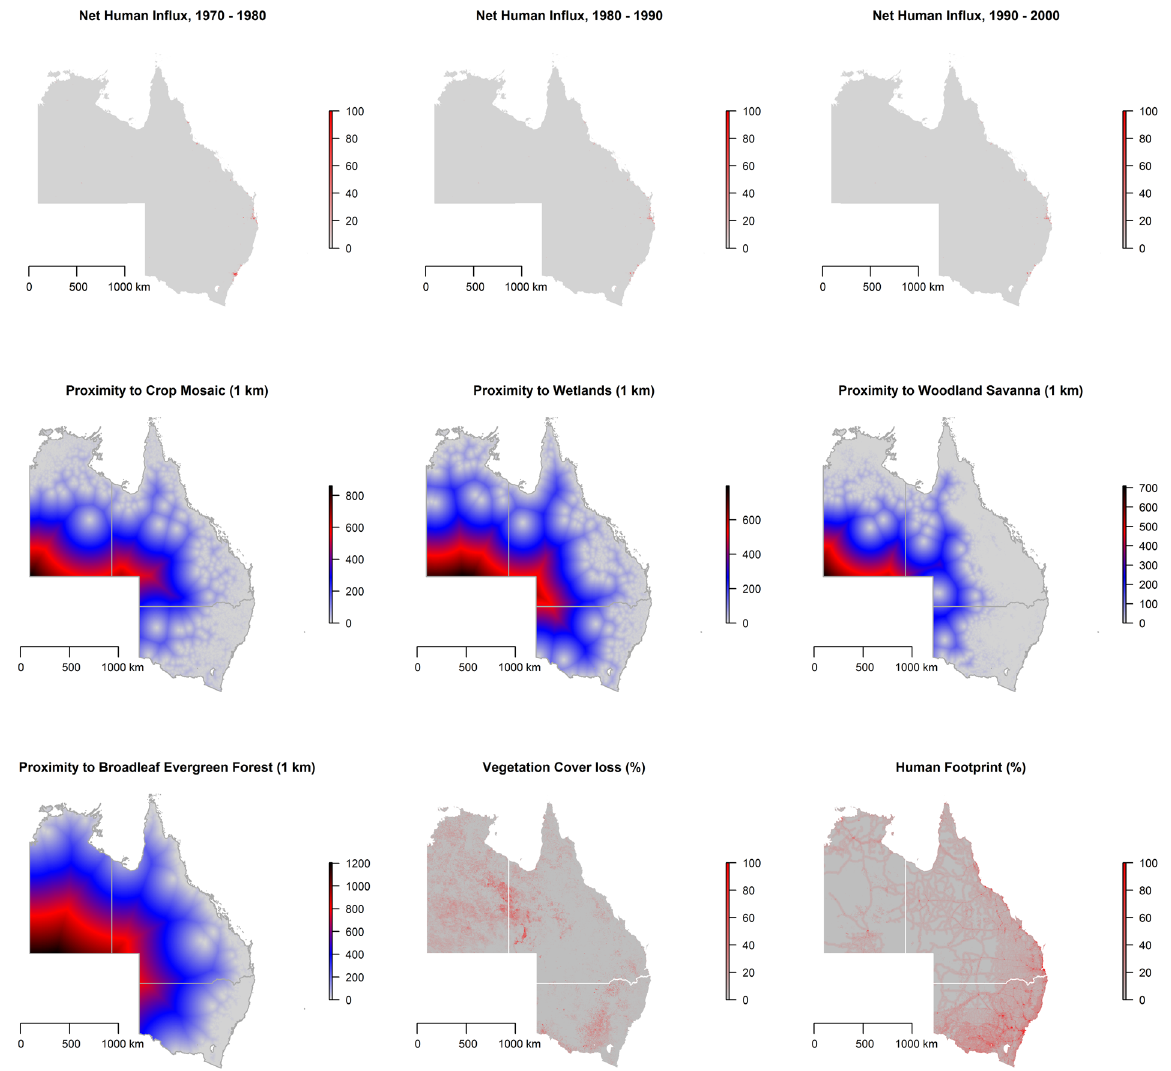
Figure 3. Landscape feature distribution maps. The first three maps in the top row represent the net human migration during the periods 1970–1980, 1980–1990, and 1990–2000, respectively. Each pixel in each of the subsequent four rasters represents the distance between that 1 km 2 area and the nearest pixel containing that specific land cover feature. The last two rasters in the bottom row represent percent vegetation loss and the human footprint, respectively. All maps created in R (v. 3.3.1) 42